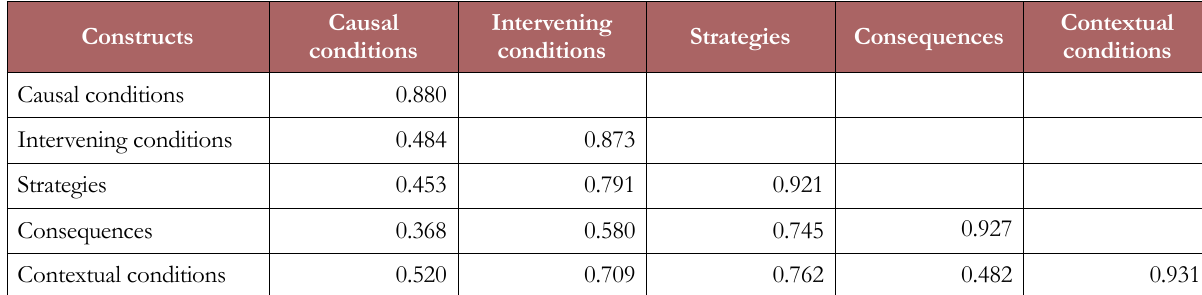
Table 12. Discriminant validity: Fornell-Larcker Criterion